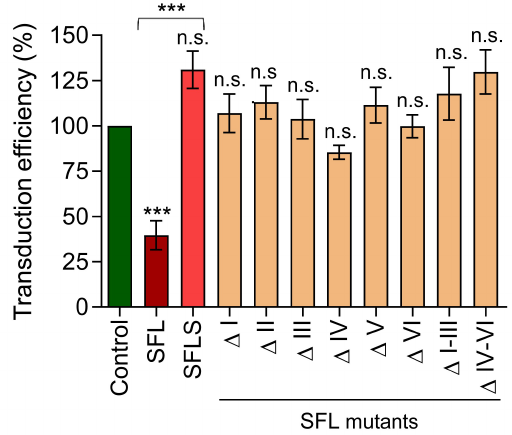
Figure 4. Deletions within the RAA abrogate SFL-mediated suppression of viral infectivity. HIV reporter particles containing a luciferase encoding vector genome and harboring the glycoprotein of vesicular stomatitis virus (VSV-G) were produced in the presence and absence of SFL, SFLS, or SFL mutants. Transfection of a GFP expression plasmid served as negative control. At 72 h post- transfection, supernatants were collected and equal volumes used for transduction of HEK293T cells. At 72 h post-transduction, the luciferase activity in cell lysates was measured. Transduction measured for control particles produced in the absence of SFL was set as 100%. The average of five biological replicates carried out with technical triplicates is shown; error bars indicate SEM. One-way analysis of variance (ANOVA) with Dunnett‘s multiple comparison test was performed to determine whether differences between cells expressing GFP (control) and SFL, SFLS, or SFL mutants were statistically significant (not significant [n.s.]; ***, p ≤ 0.001; n = 5). Unpaired Student’s t-test was performed to test whether differences between cells expressing SFL or SFLS were statistically significant (***, p ≤ 0.001; n = 5). SFL, shiftless; SFLS, shiftless short.